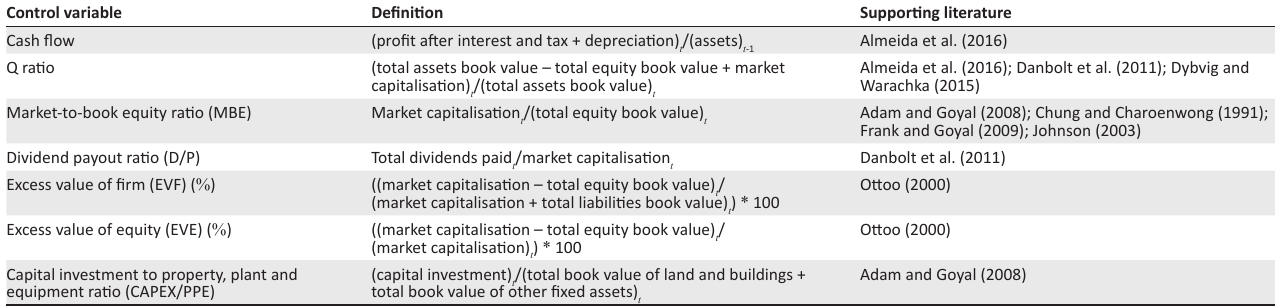
TABLE 1: Summary of control variables as proxies for variations in growth opportunities. Control